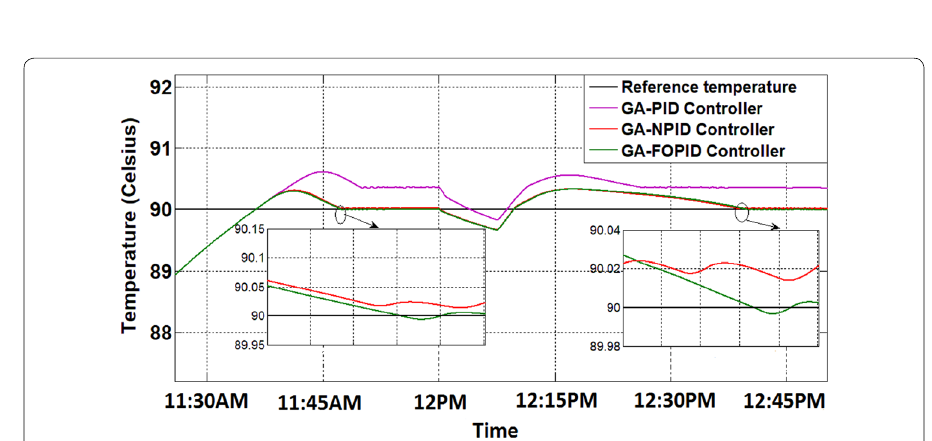
Fig. 11 Temperature response using different controllers with 5%